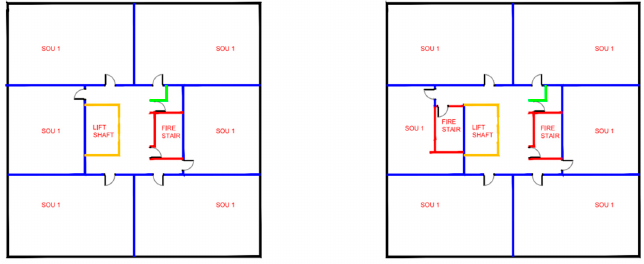
Figure 3. Case #2—Performance ( left ) and DTS ( right ) solutions.